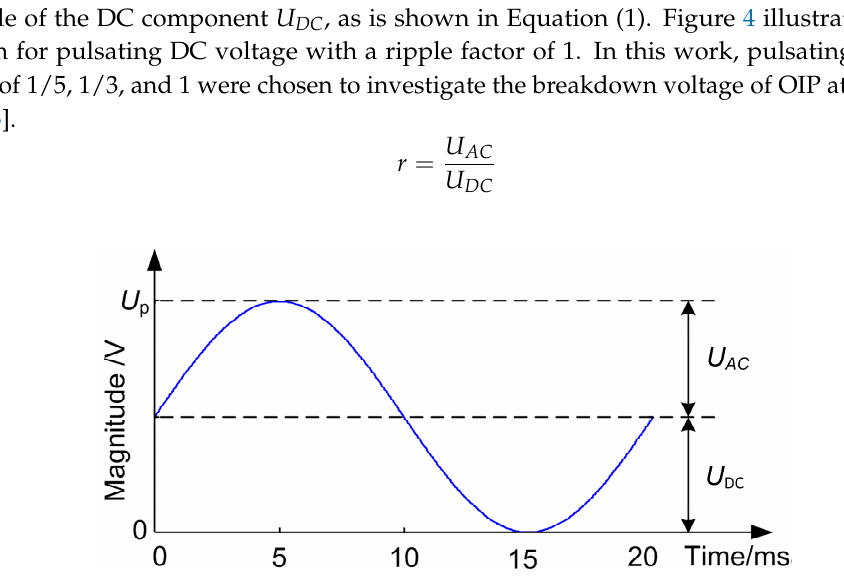
Figure 4. Typical pulsating direct current (DC) voltage waveform.